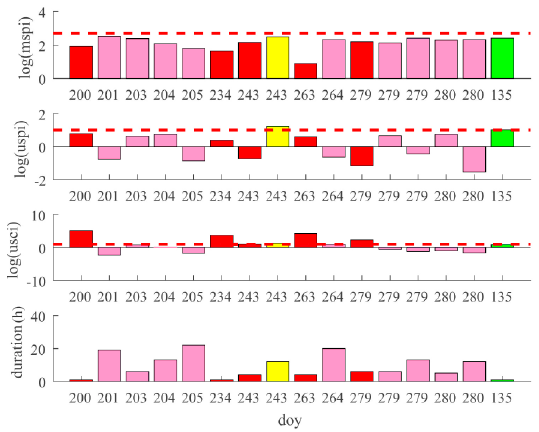
Figure 5. Unhealthy state statistics of C011. The subfigures correspond to mspi, uspi, usci, and duration of the unhealthy states, respectively. Green bars represent Type 2 unhealthy states. Red bars represent Type 3 unhealthy states. Yellow bars represent Type 4 unhealthy states. Pink bars represent Type 5 unhealthy states.